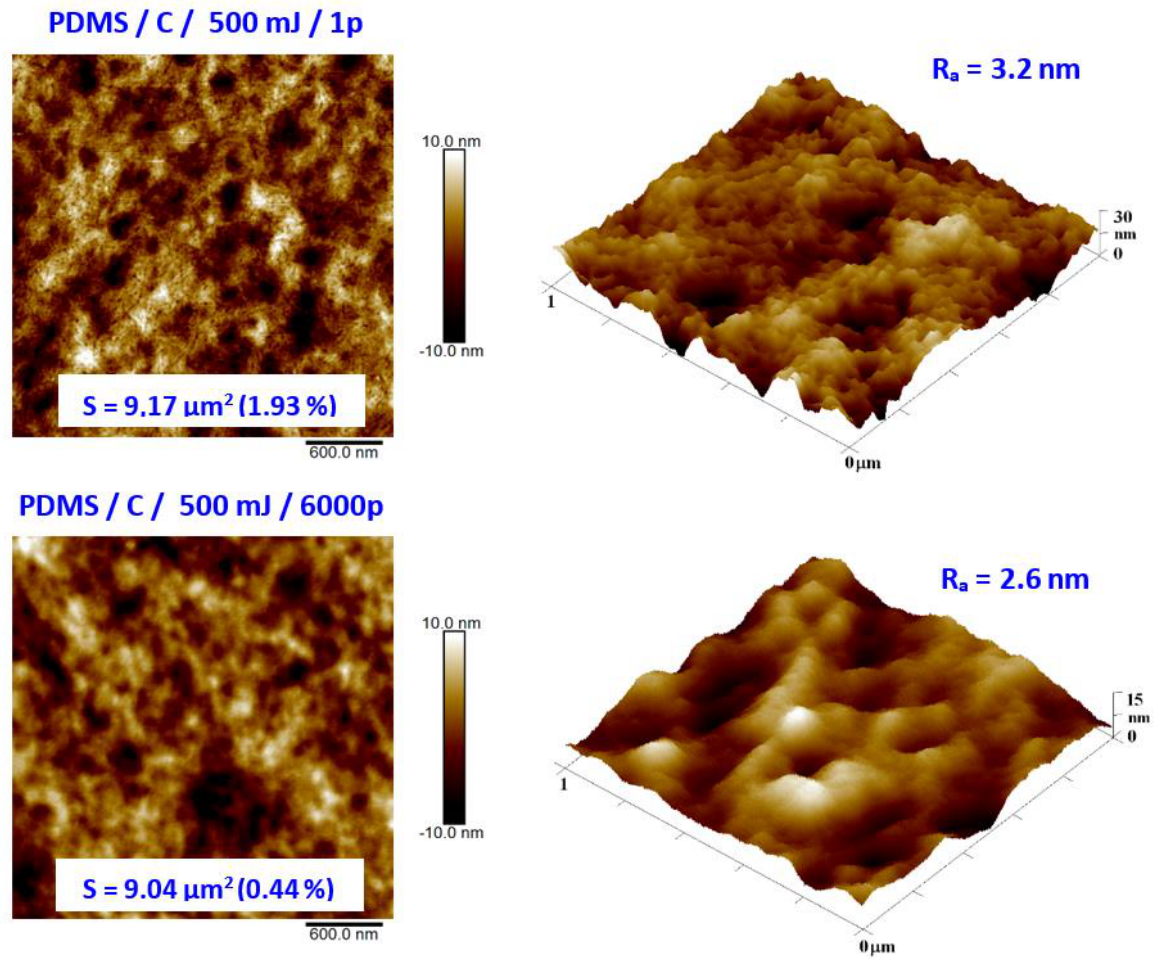
Figure 6. Surface morphology of PDMS-C film treated with high-energy excimer laser with a laser energy of 500 mJ and numbers of pulses of 1 and 6,000. The selected image areas are 3 × 3 μm 2 (2D) and 1 × 1 μm 2 (3D). Effective surface area (S) and average surface roughness (R a ) is introduced.